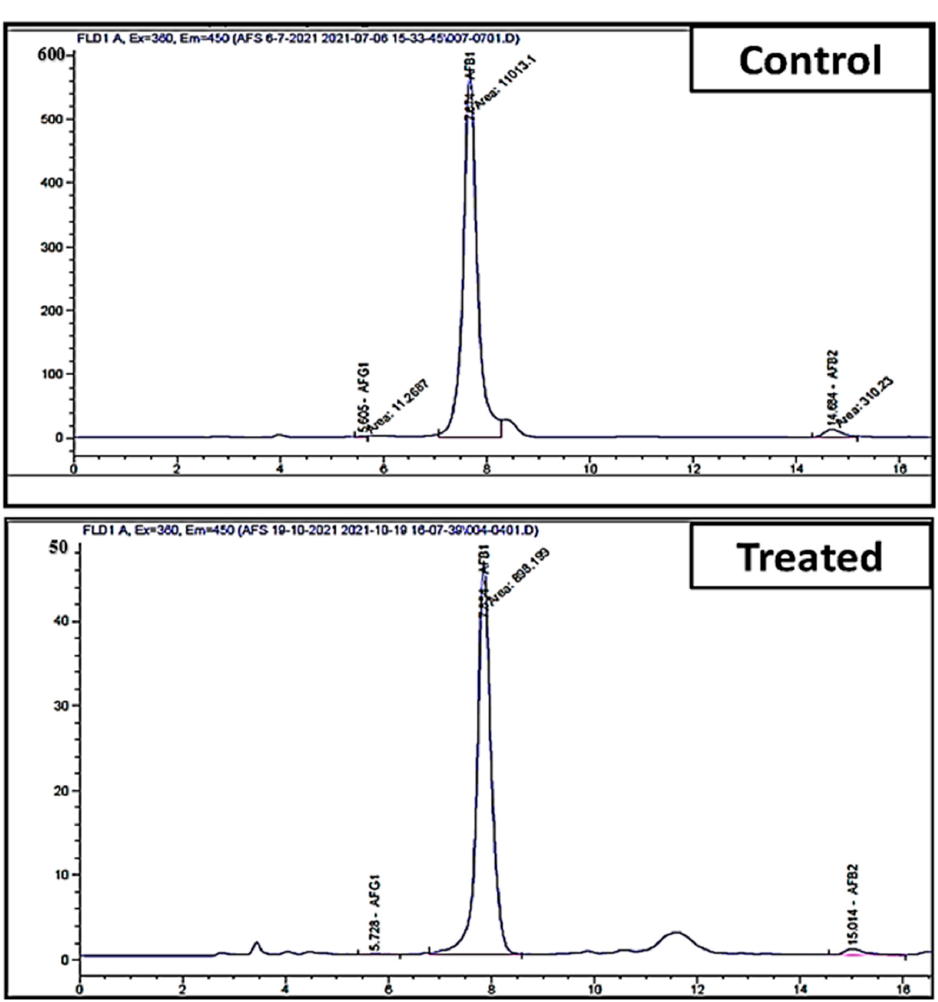
Figure 4. HPLC chromatogram of aflatoxin level in control (infected maize with A. flavus ) and treated (infected maize treated with endophytic A. fumigatus ).